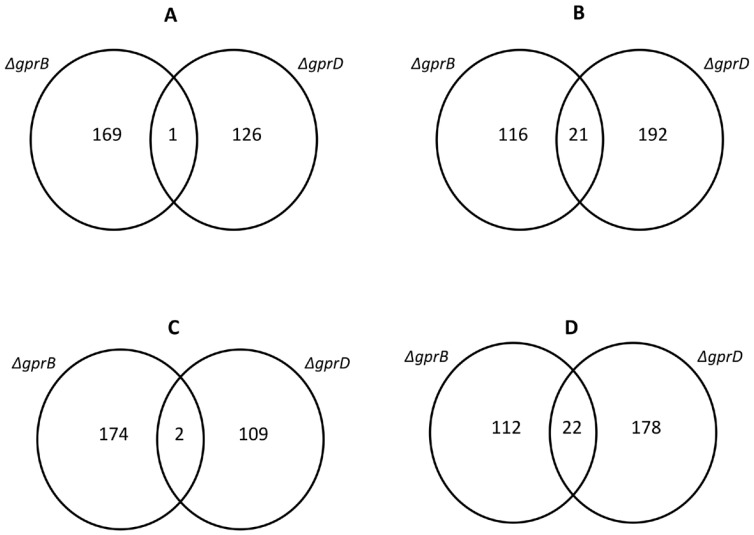
Venn diagram showing the genes specifically expressed in the ΔgprB and ΔgprD mutant strains.(A) and (B) show the genes up-regulated at 24 and 48 hours, respectively, while (C) and (D) show the genes down-regulated at 24 and 48 hours, respectively.